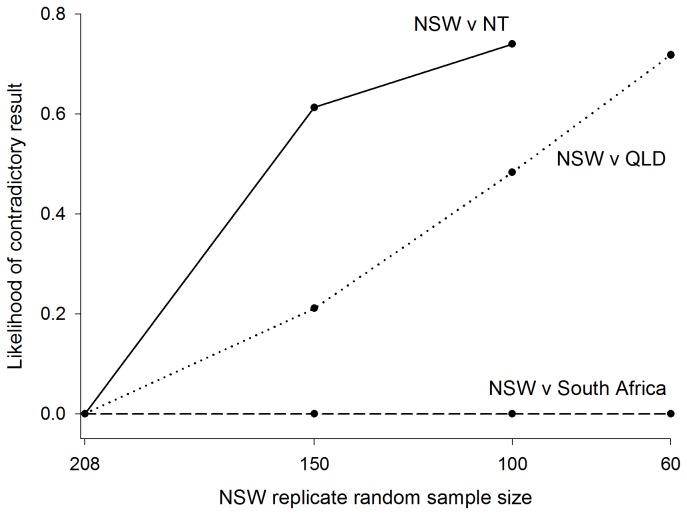
Likelihood of pairwise result contradicting that of the original analysis.Likelihoods computed based on 10,000 replicate random re-samples of the NSW population at varying sample sizes. Y-intercept represents original NSW population (n = 208).